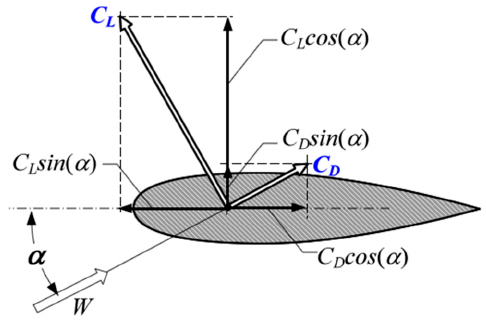
Figure 6. Aerodynamic coefficients acting on a Darrieus wind turbine blade element [36].